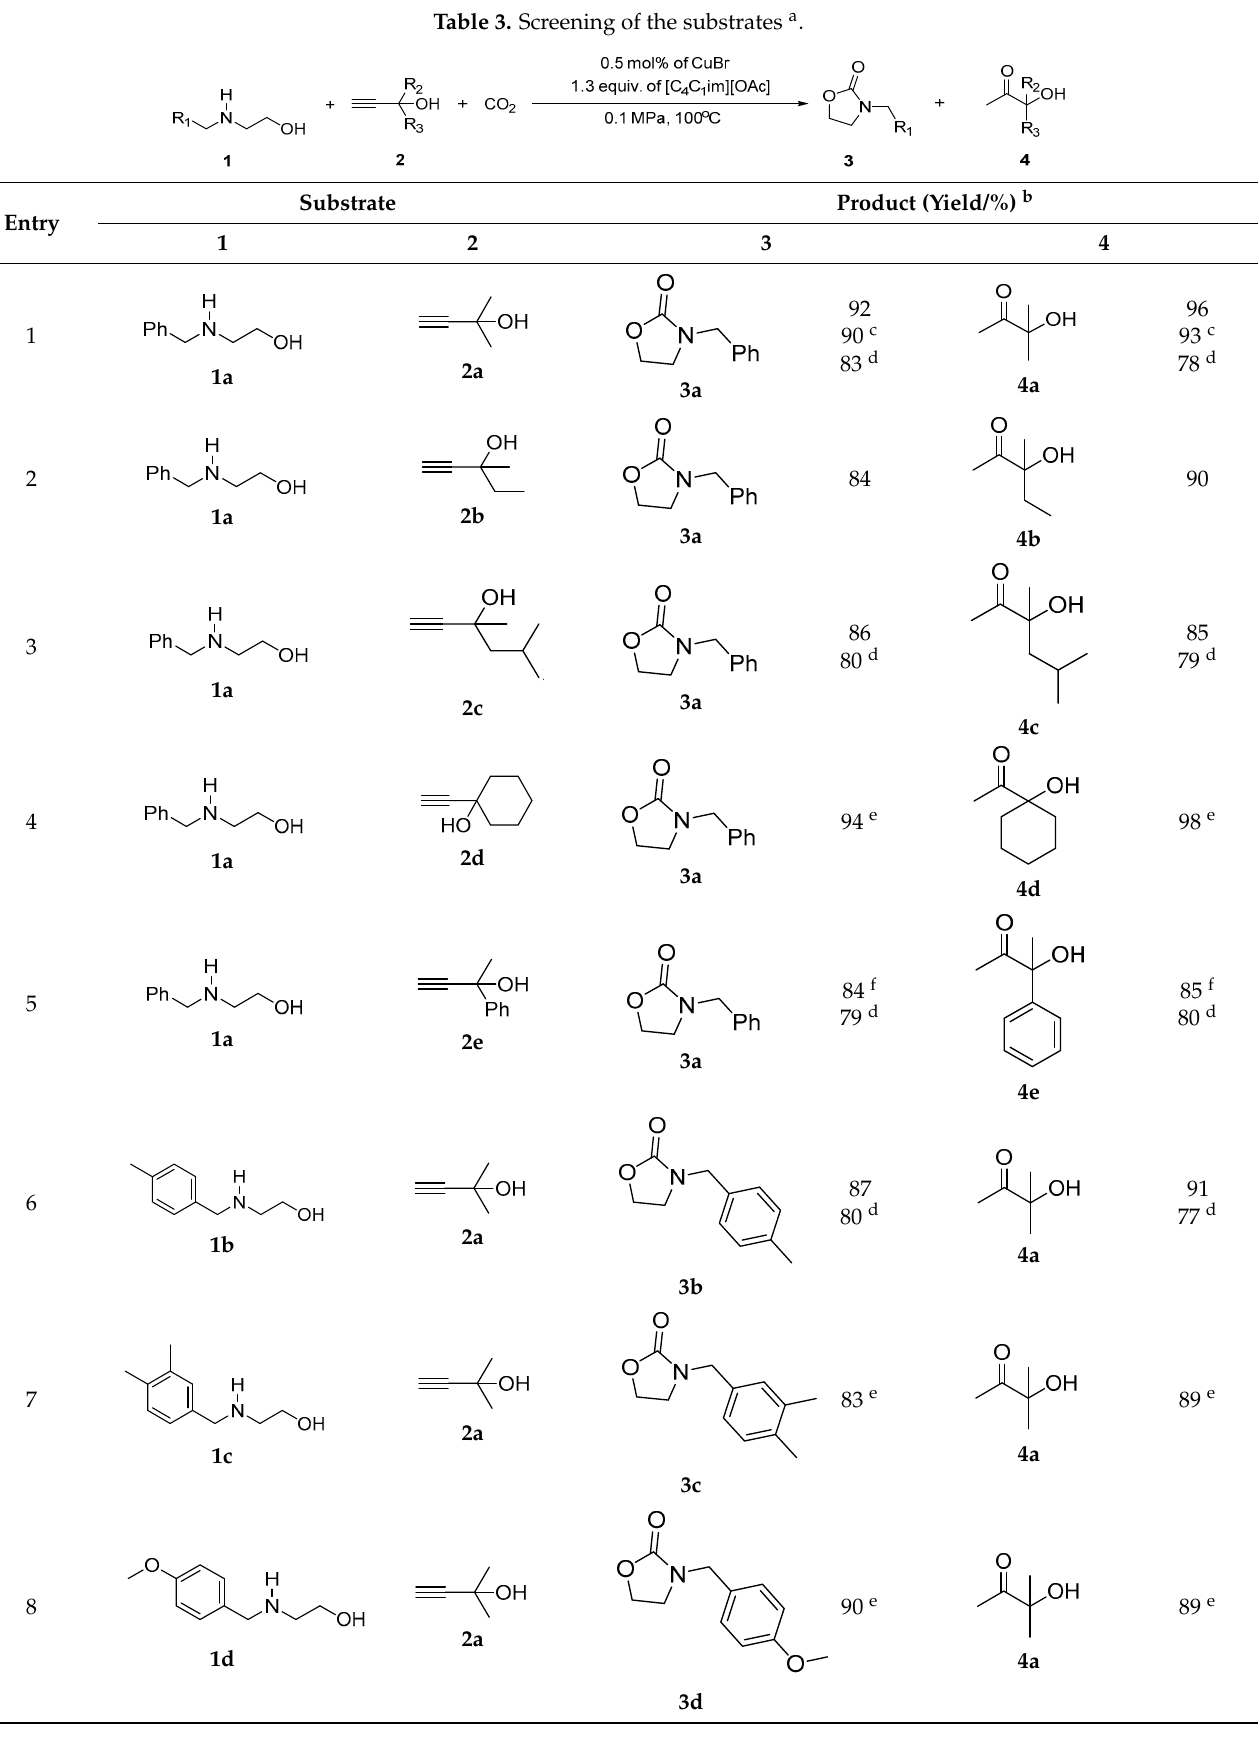
Table 3. Screening of the substrates a .